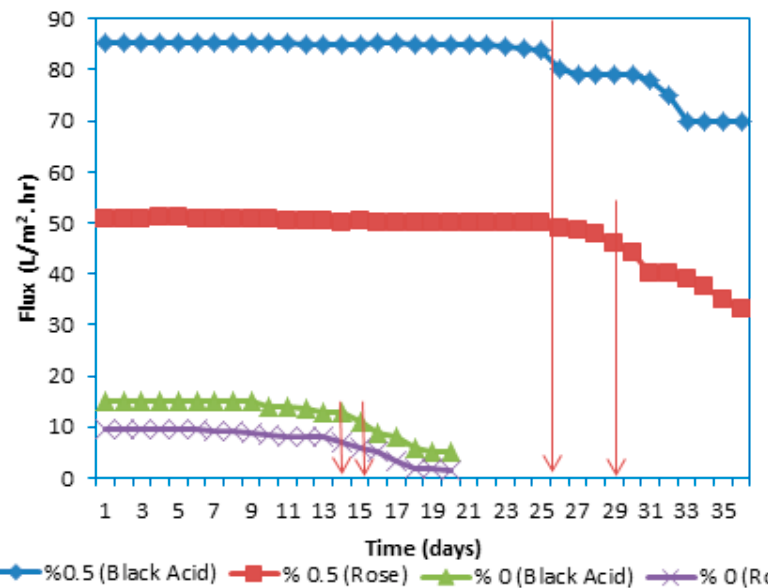
Figure 10. The e ff ect of GO in casting solution on long-term of the prepared Figure 10. The effect of GO in casting solution on long ‐ term of the prepared membrane.